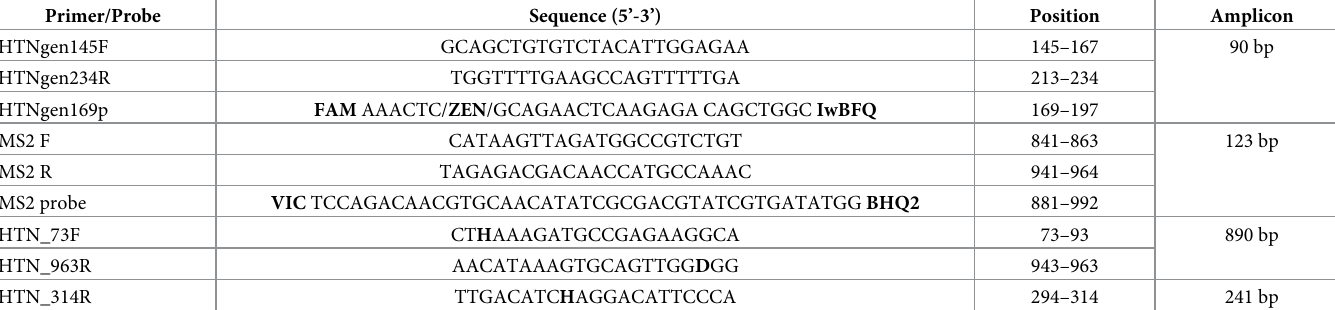
Table 1. Nucleotide sequences of primers and probes used in hantavirus RT-qPCR and Nested RT-PCR assays.